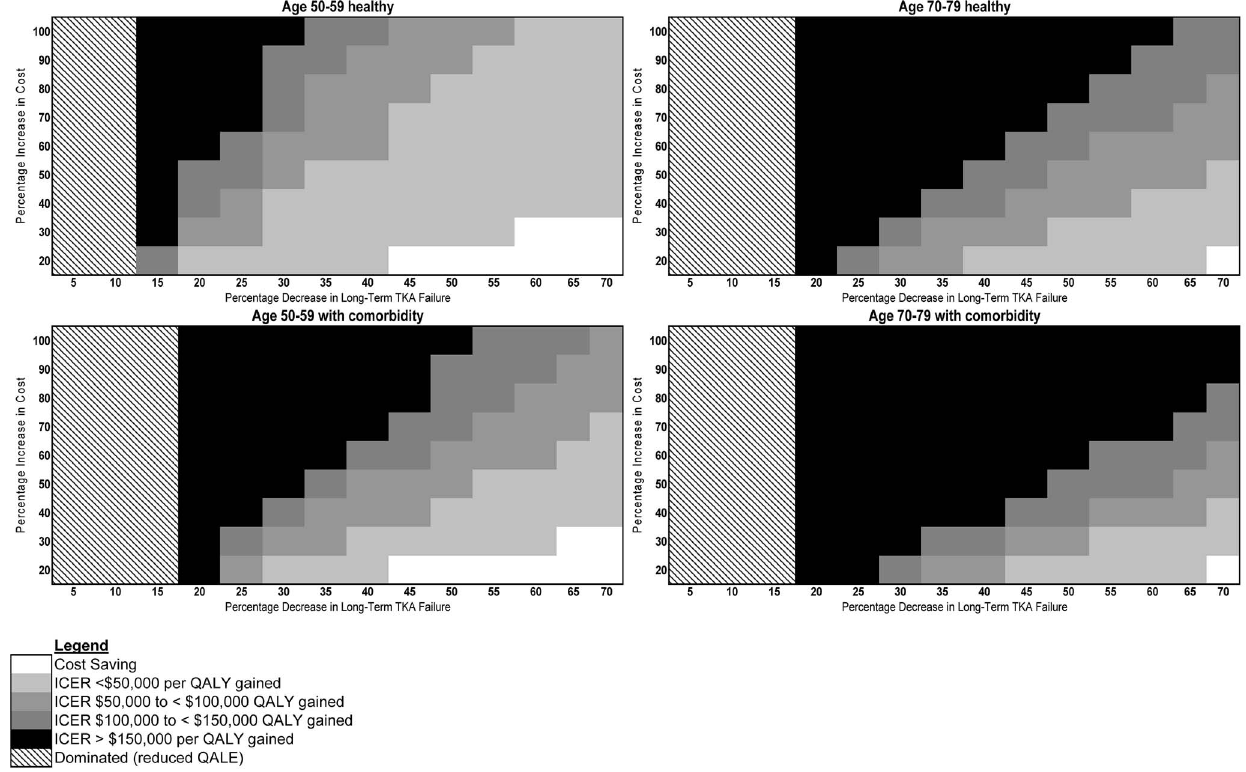
Figure 3. Implant cost and long-term TKA failure thresholds in a scenario where the base short-term failure rate doubles. Each shaded area represents implant cost increases (vertical axis) and failure rate reductions (horizontal axis) required to achieve a given ICER range (see Legend contained in Figure) among the four primary cohorts in 2010 US $ per quality-adjusted life year (QALY) gained, compared with standard TKA. Areas with black and white diagonal lines indicate assumptions under which innovative implants offer lower QALE for greater cost compared to standard implants (i.e., such an innovative implant is ‘‘dominated’’ by the standard implant).